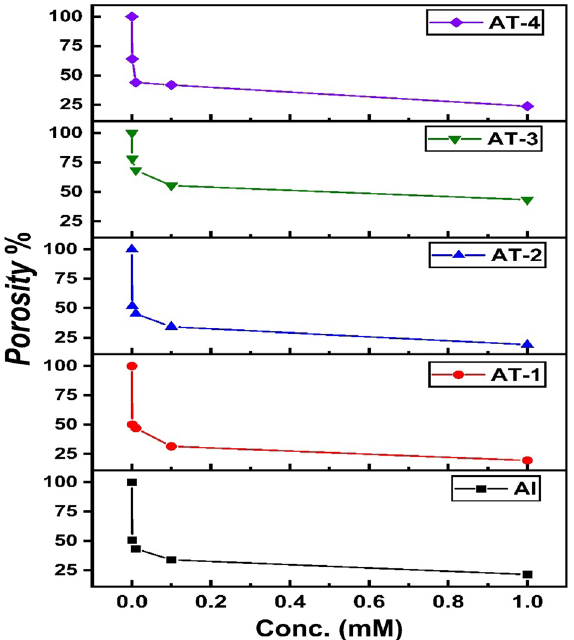
Figure 4. Porosity percentage as a function of 2-MBT concentrations for Al and Al–Ti